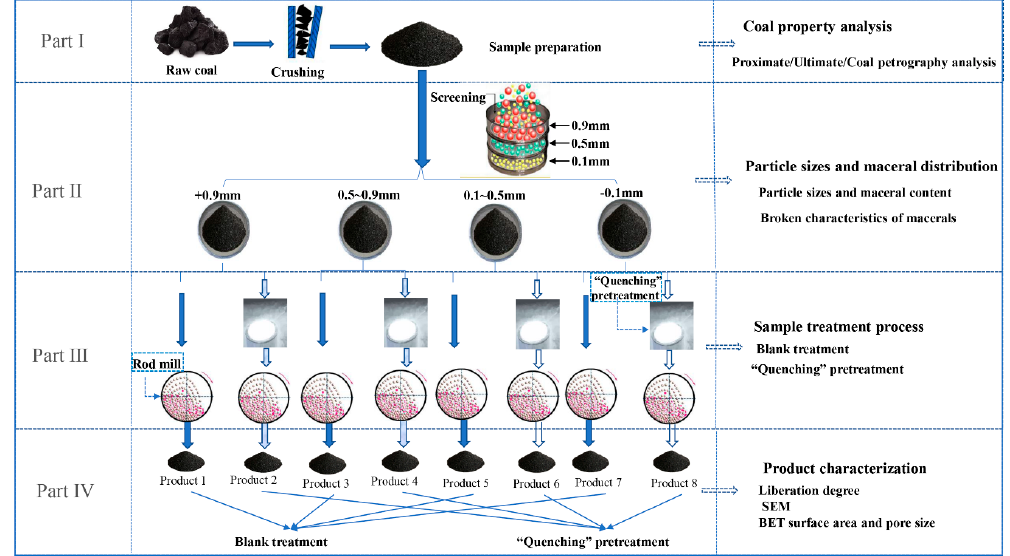
Figure 2. Illustration of the experiment process. BET—S. Brunauer, P. Emmett and E. Teller; SEM—Scanning electron microscope.